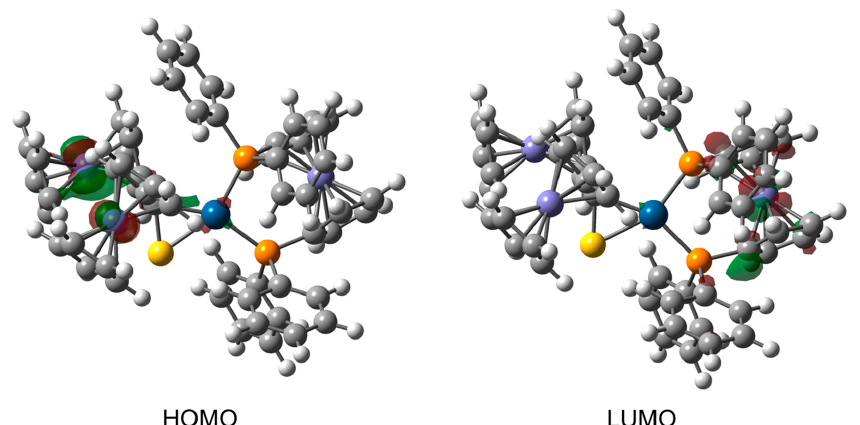
Figure 11. Contours of the highest occupied molecular orbital and lowest unoccupied molecular orbital for complex 3c . Their parts possessing either positive or negative sign are colored red and green, respectively. The contours are plotted with an isovalue of 0.05